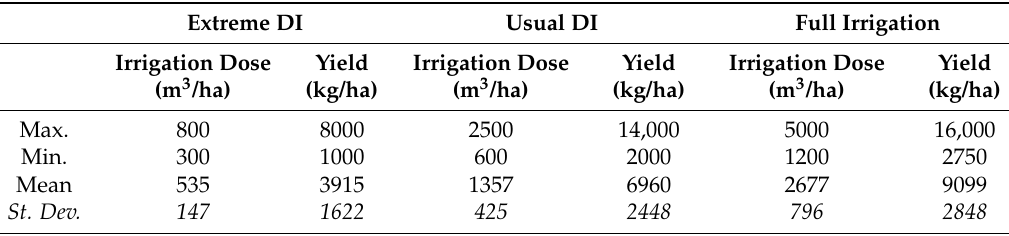
Table 2. Subjective water yield response descriptive